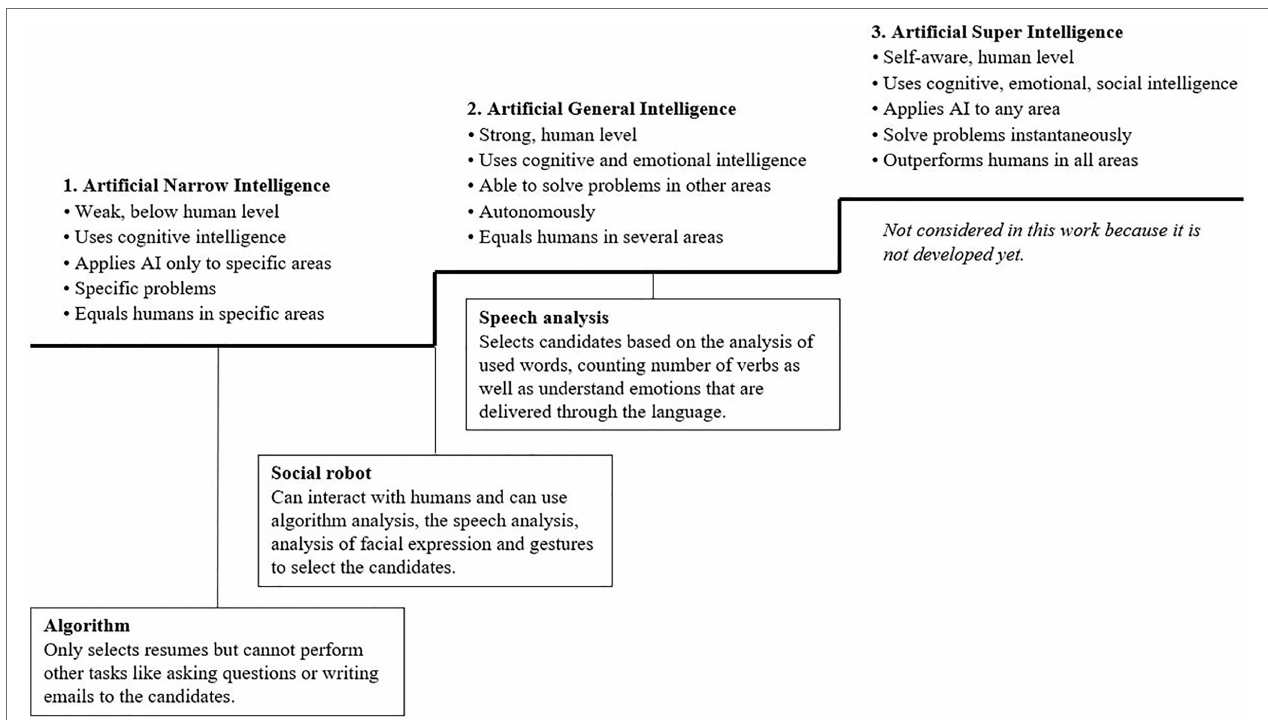
FIGURE 1 | Classification of artificial intelligence and placement in HR. Classification of three AI stages is provided by Kaplan and Haenlein